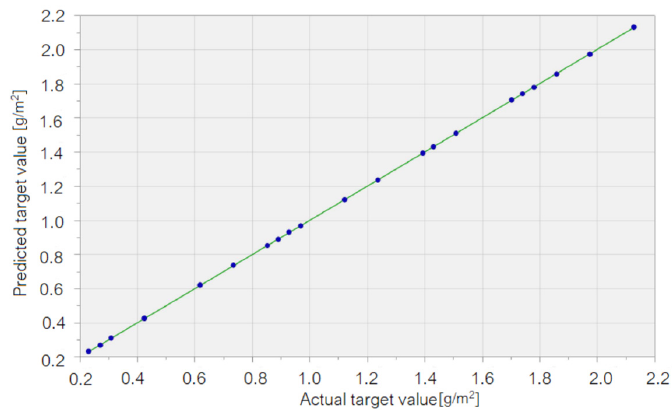
Figure 6. The computed values (called “predicted target values”) vs. the recorded ones (called “actual target values”) in the GRNN model for the Cu sample.